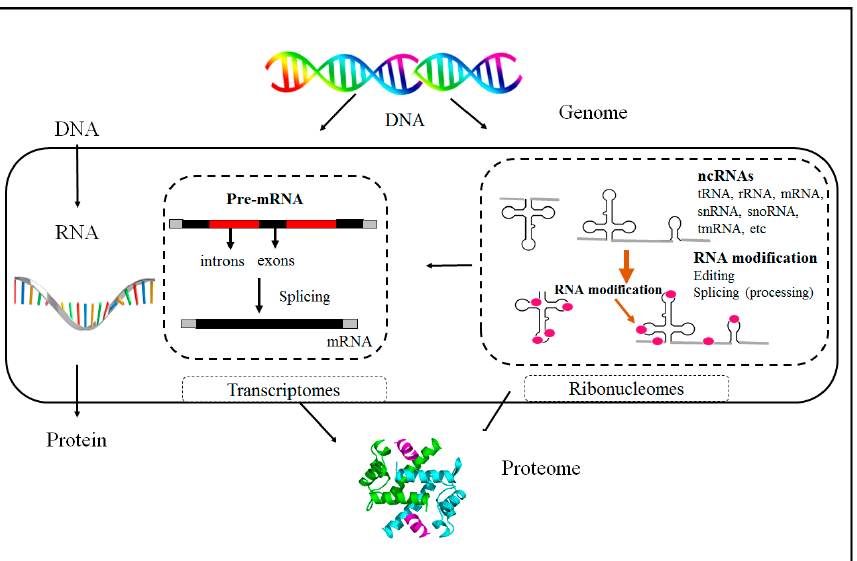
Figure 1. The relationship between epigenetics and genetics: As genetic information is transferred from DNA to RNA and then to protein, epigenetic information is applied as changes to DNA, RNA, and protein and can affect the function of the proteome.